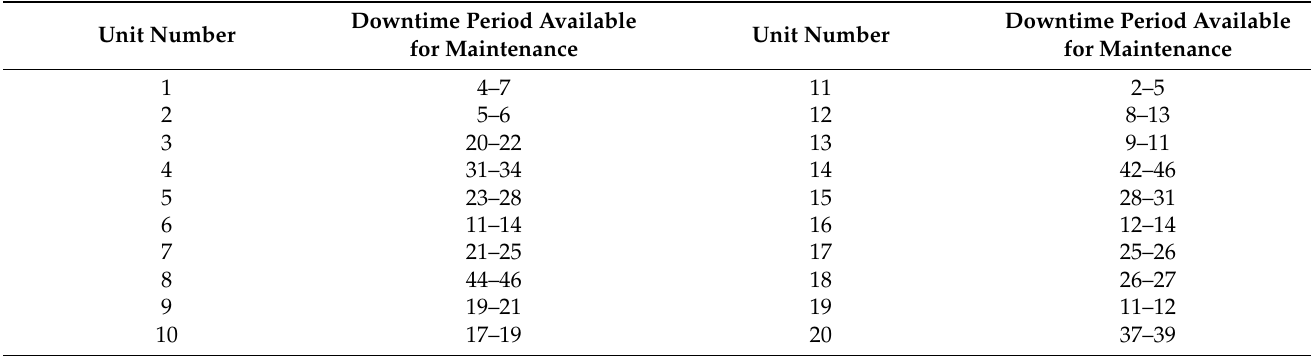
Table 1. The maintenance schedule of each unit in the RTS–GMLC test